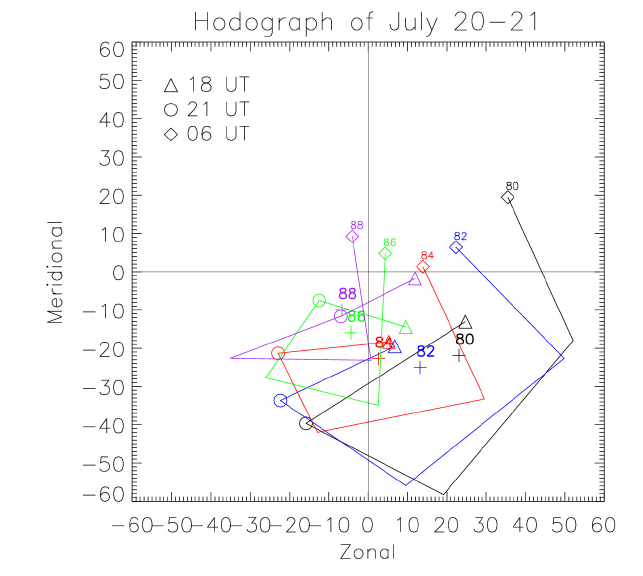
Figure 11. Hodograph of winds measured by the KSS meteor radar, on July 20 at 18, 21, 00, 03, and 06 UT, at the heights of 80, 82, 84, 86, and 88 km. Symbols for each time are indicated in the figure, and each altitude level is distinguished by different colors and indicated near the respective curve. The crosses indicate the average wind calculated on the time interval for each altitude distinguished by the